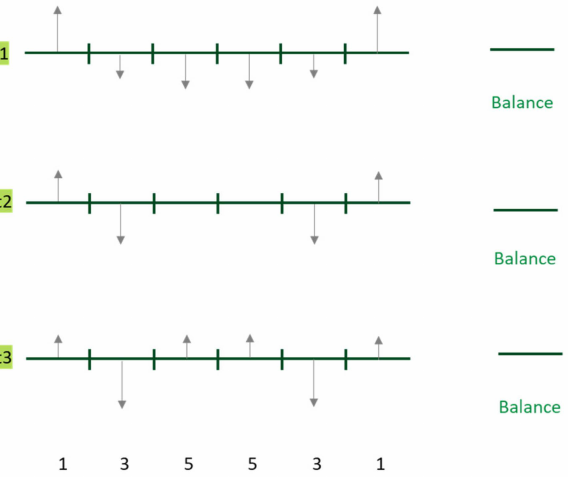
Figure 13. 48th order tangential electromagnetic force distribution of ‘V’ shaped structure. Combined with the analysis of the 48th order noise from the previous rotor skew angle, we used the previous 1.6 ◦ skew angle scheme of each stacked piece to process and manufacture the 1.6 ◦ electric drive sample of ‘V’ shape, and compared it with the previous original ‘liner’ shape sample and the 1.6 ◦ skew angle sample. The results are shown in Figure 14. It can be seen from the results that the 48th order noise level of 1.6 ◦ with the ‘V’ shape is the lowest under the commonly used 5500 rpm of the motor. Due to the absence of torsional electromagnetic force at 2000 rpm, the acceleration noise linearity is more peaceful.